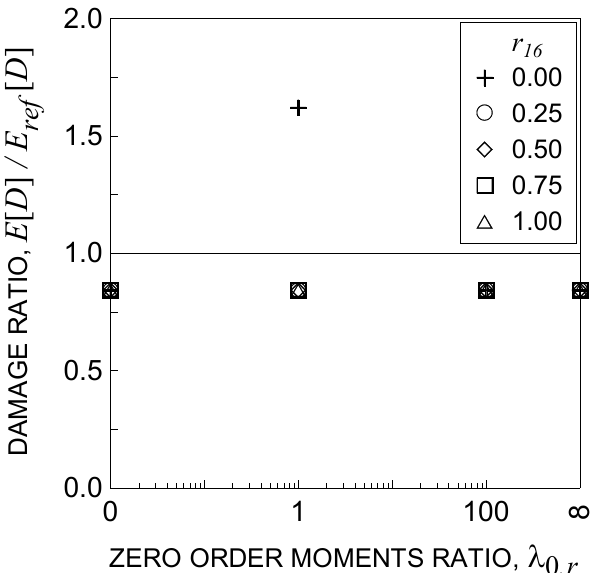
E D : completely overlapped ref